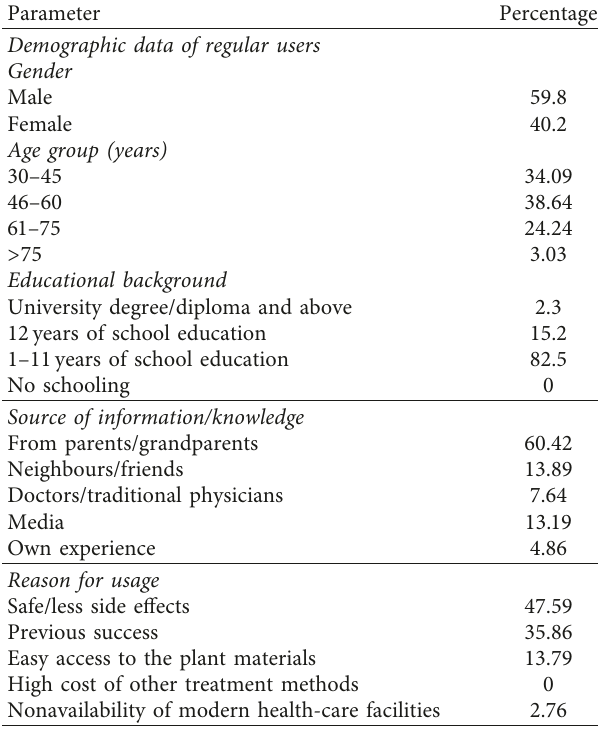
Table 1: Statistics on the usage of herbal therapeutics.